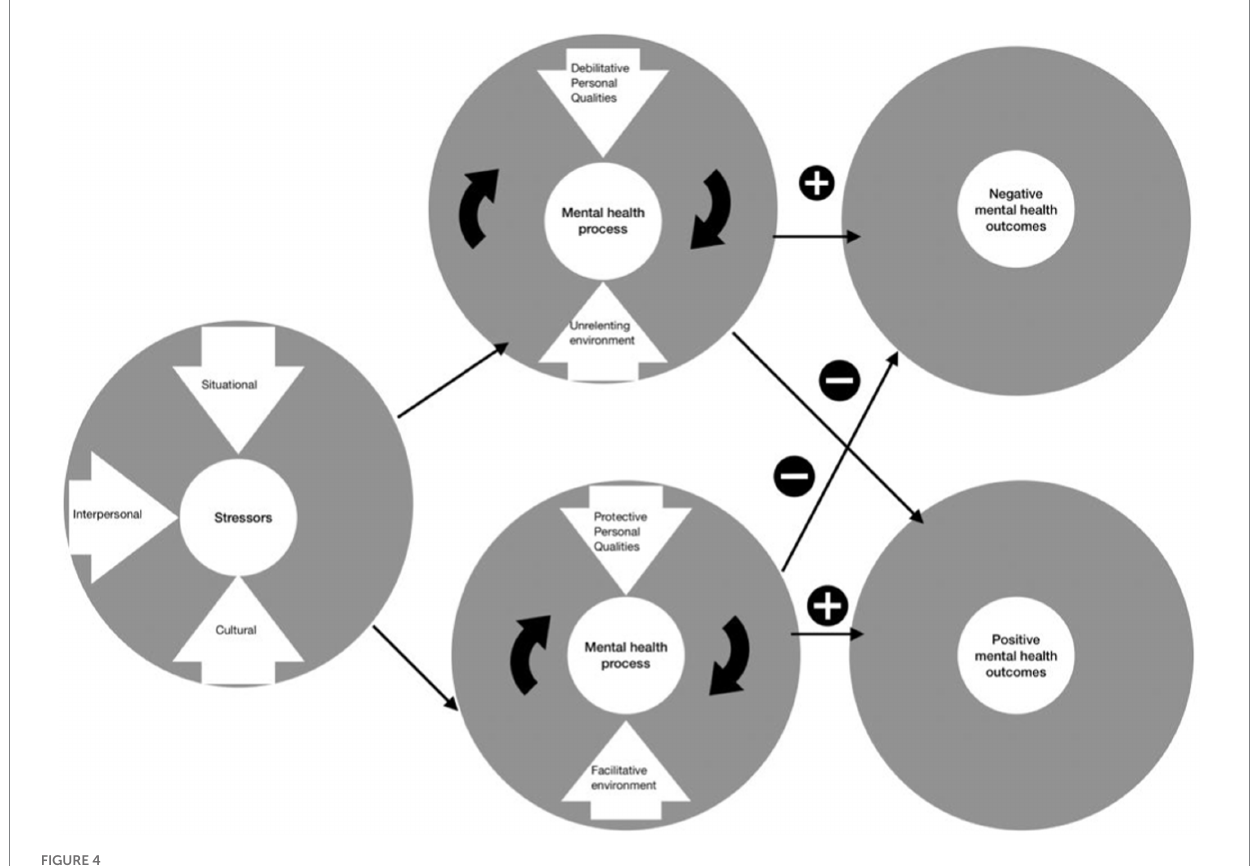
FIGURE 4 Overview over a mental health